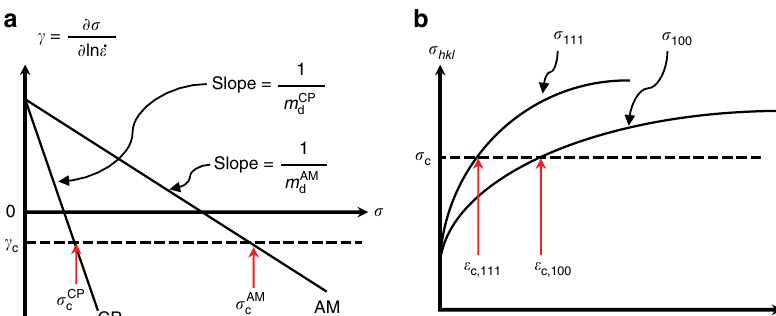
Fig. 4 Theoretical strain-rate sensitivity and strain-hardening behavior of Inconel 625. a Schematic of strain-rate sensitivity as a function of fl ow stress for conventionally processed and additively manufactured Inconel 625 at a given temperature, where γ c (<0) denotes the critical value of γ for the onset of serrations, and σ CP and σ AM are the corresponding critical stresses for initiating serrated fl ow for CP-IN625 and AM-IN625, respectively. b Schematic of hkl - c c dependent strain-hardening behaviors showing that for a given grain-level critical stress for serrations, due to their higher strain hardening rate, <111>//LD grains would reach the critical stress at a lower strain than <100>//LD grains, which have a lower strain hardening rate